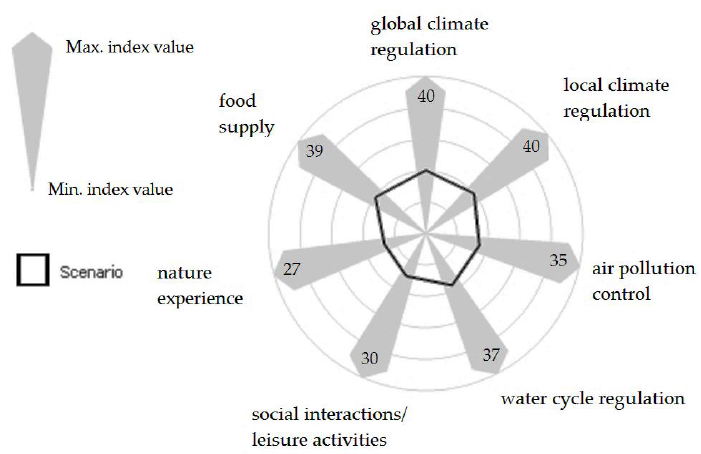
Figure 4. Spider diagram in GISCAME with average index values for Halle.